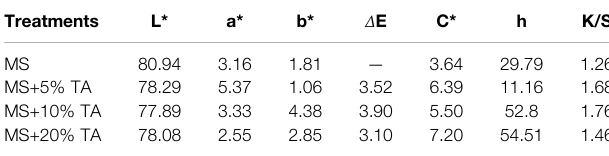
TABLE 1 | Effect of TA concentration on the colorimetric data of dyed samples.